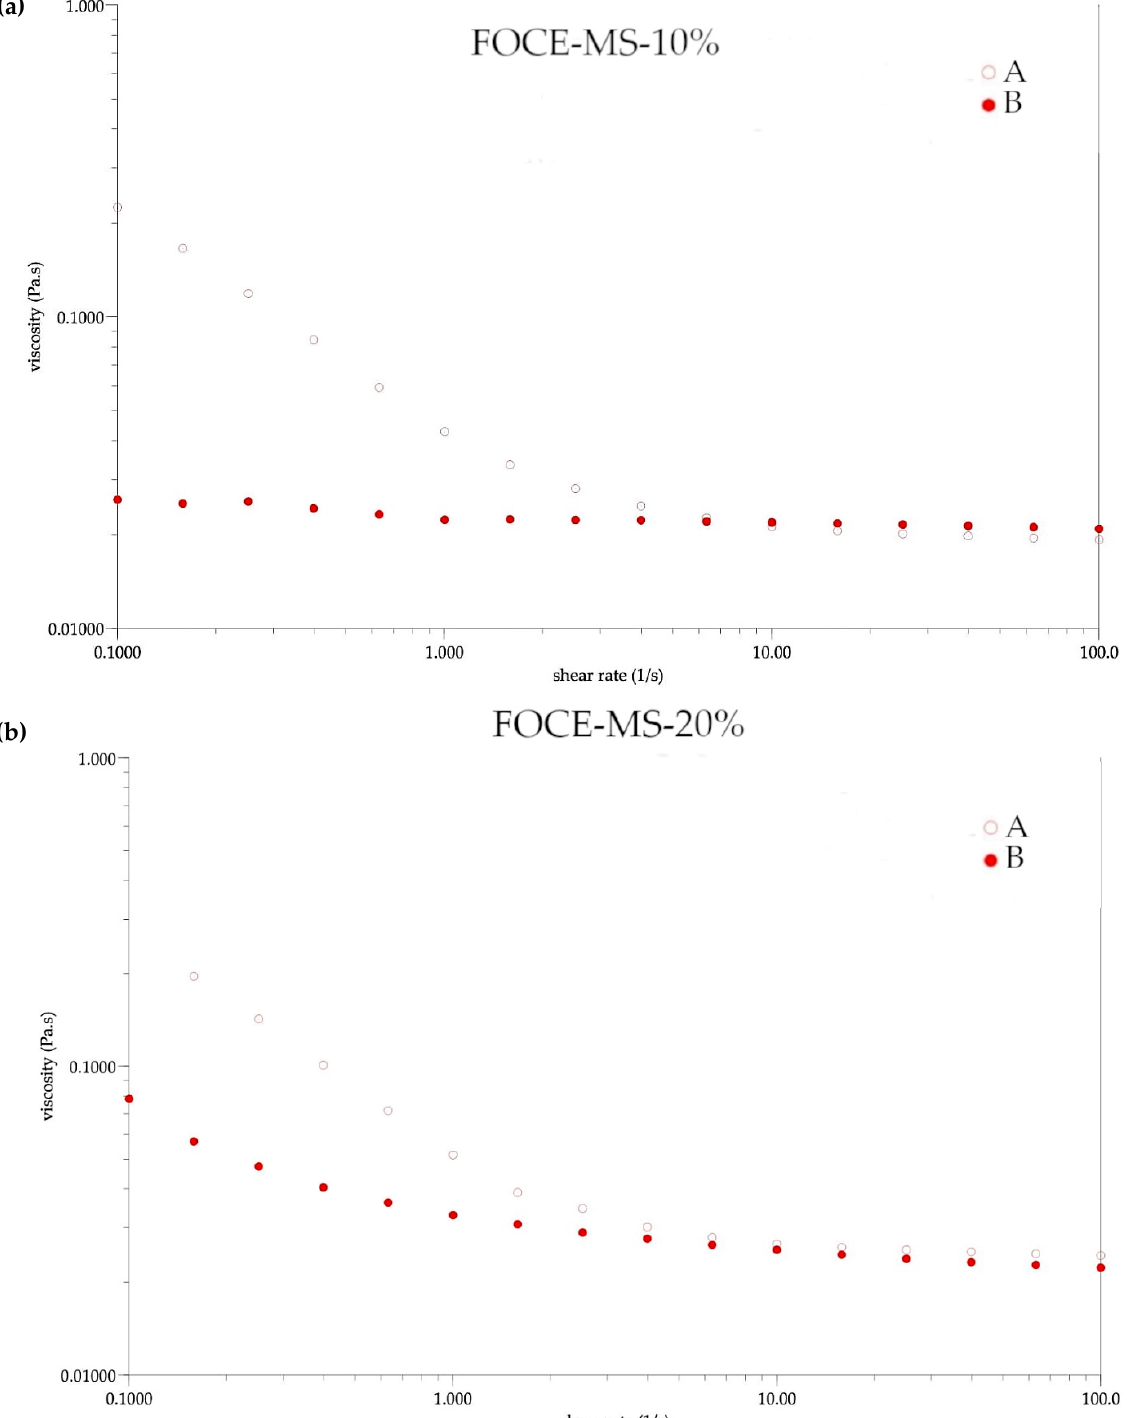
Figure 4. The flow curves of emulsions with FOCE before spray drying A and after reconstitution B. ( a ) FOCE-MS-10%— FOCE-based emulsion with 10% of flaxseed oil; ( b ) FOCE-MS-20%—FOCE-based emulsion with 20% of flaxseed oil.